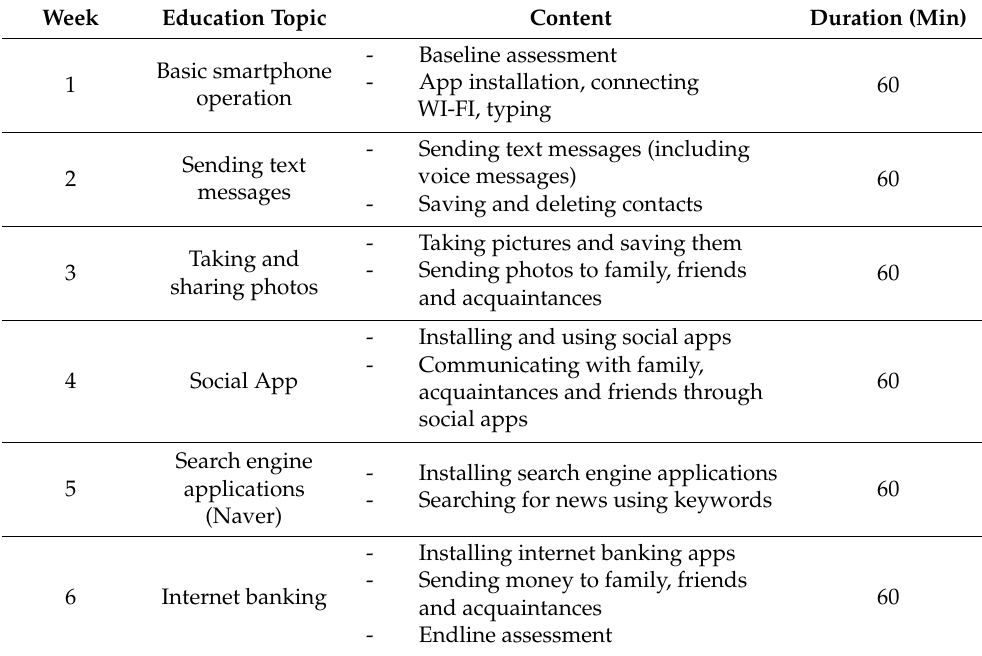
Table 1. Digital literacy education